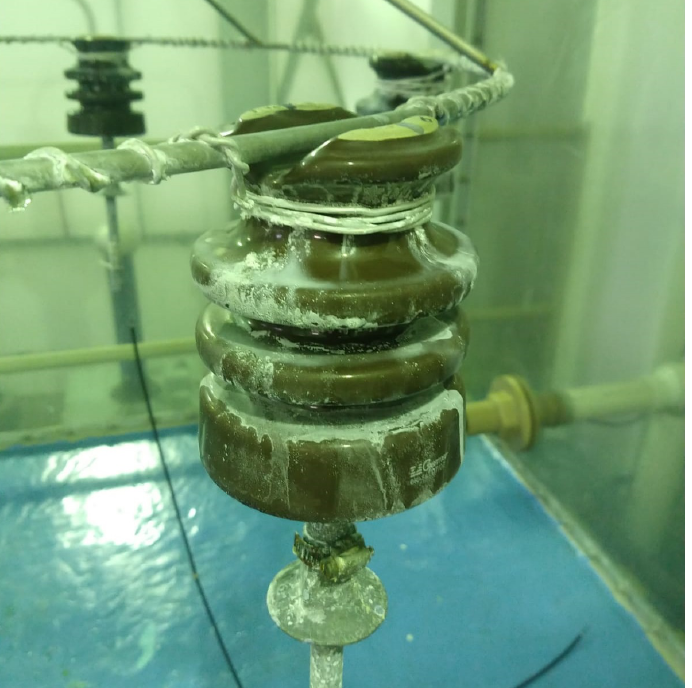
Figure 4. Insulator with salt contamination accumulated on its surface at the end of the